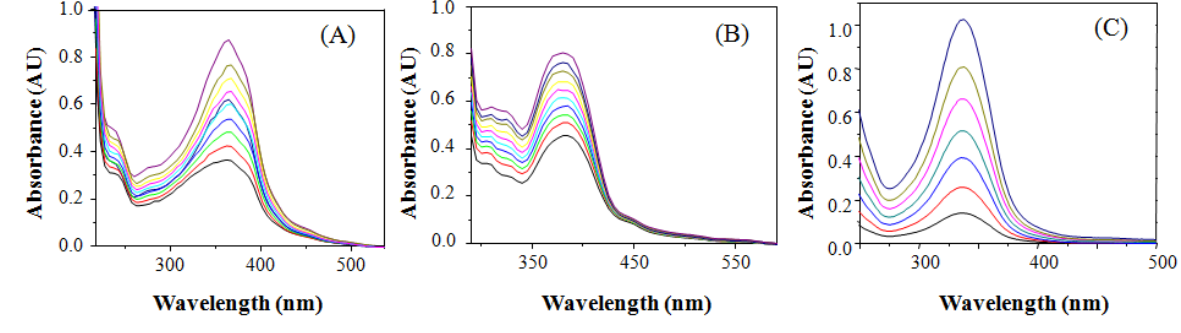
Figure 1. Absorption spectra of ( A ) BS1 ; ( B ) BS2 ; and ( C ) compound 3 ; all in aqueous solution (30 mM HEPES buffer, pH 7.4, 1%